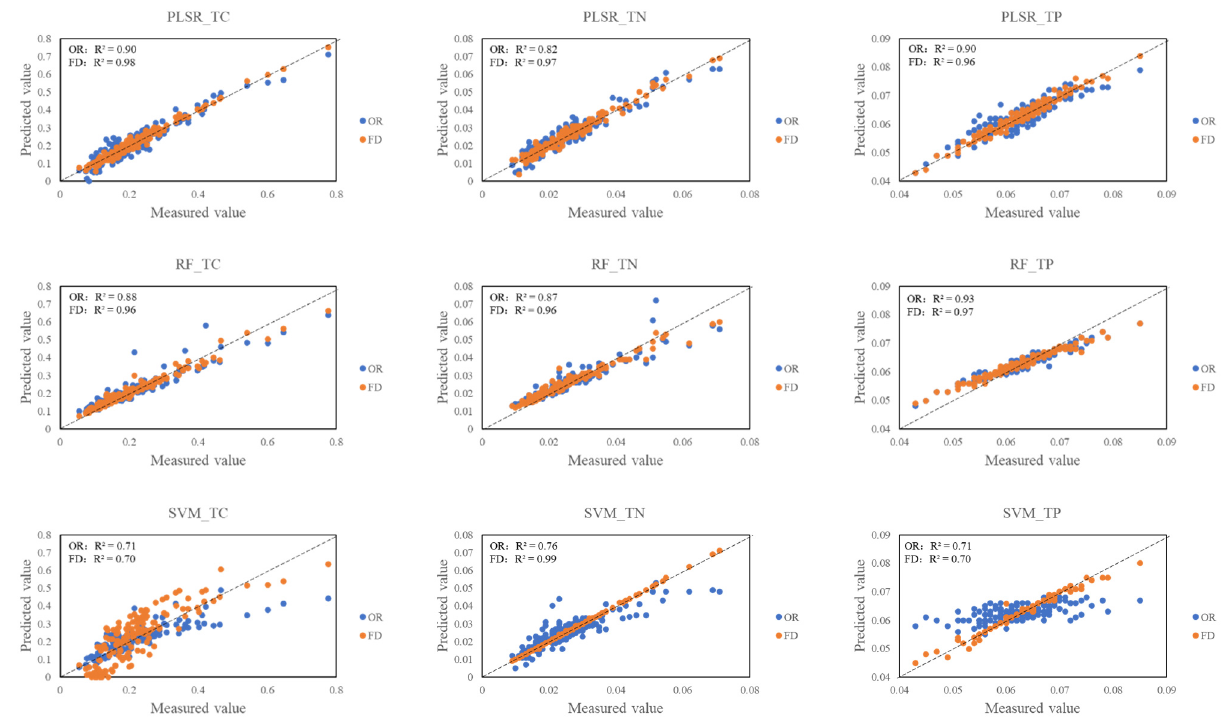
Figure 5. Modelling results of the carbon, nitrogen, and phosphorus levels in inverted wetland soils using three models: partial least-squares regression (PLSR), random forest (RF), and support vector machine (SVM). OR: original reflectance; FD: first derivative reflectance.